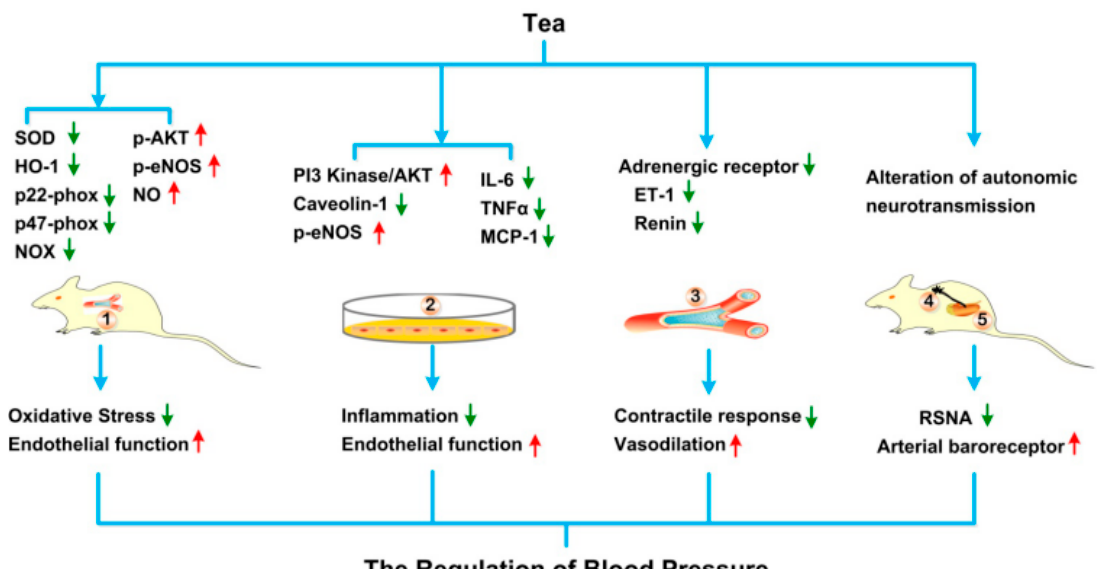
Figure 1. The underlying mechanisms of tea regulating blood pressure using animal, tissue and cell line models. After intake or adding into cell cultures, tea and its bioactive ingredients can alter several blood pressure regulating processes, including ① alleviation of the oxidative stress and improvement of the endothelial function in the aortas in vivo ; ② mitigation of the inflammation and amelioration of the endothelial function in the aortic epithelial cell lines in vitro ; ③ suppression of contractile response and improvement of vasodilation in the aortic tissues in vitro ; ④ , ⑤ inhibition of renal sympathetic nerve activity and amelioration of arterial baroreceptor. Abbreviation: SOD, superoxide dismutase; HO-1, heme oxygenase 1; NOX, NADPH oxidase; p-AKT, phosphorylated protein kinase B; p-eNOS, phosphorylated endothelial nitric oxide synthase; NO, nitric oxide; PI3 Kinase, phosphatidylinositol 3 kinase; IL6, Interleukin 6; TNF α , Tumor necrosis factor α ; MCP-1, Monocyte chemotactic protein-1; ET-1, Endothelin-1; RSNA, renal sympathetic nerve activity.